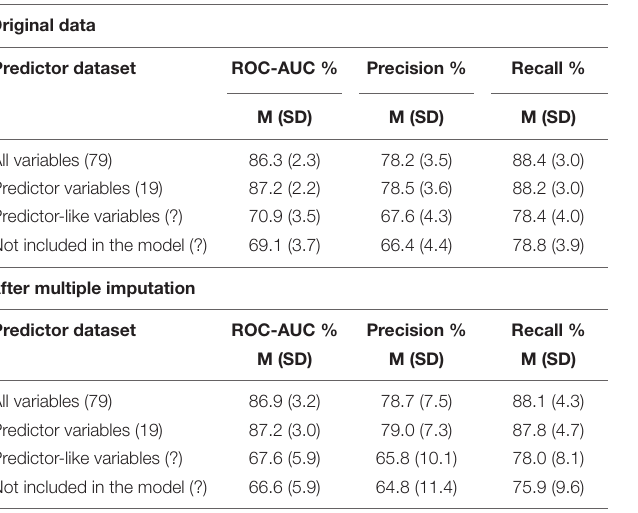
TABLE 4 | Performance metrics of the XGBoost models with different predictor sets.